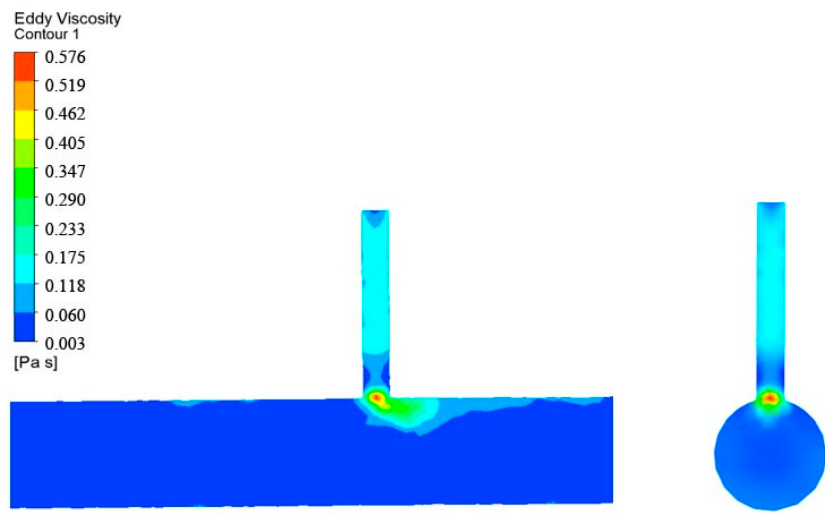
Figure 6. Eddy viscosity in the center of the water-fertilizer junction.